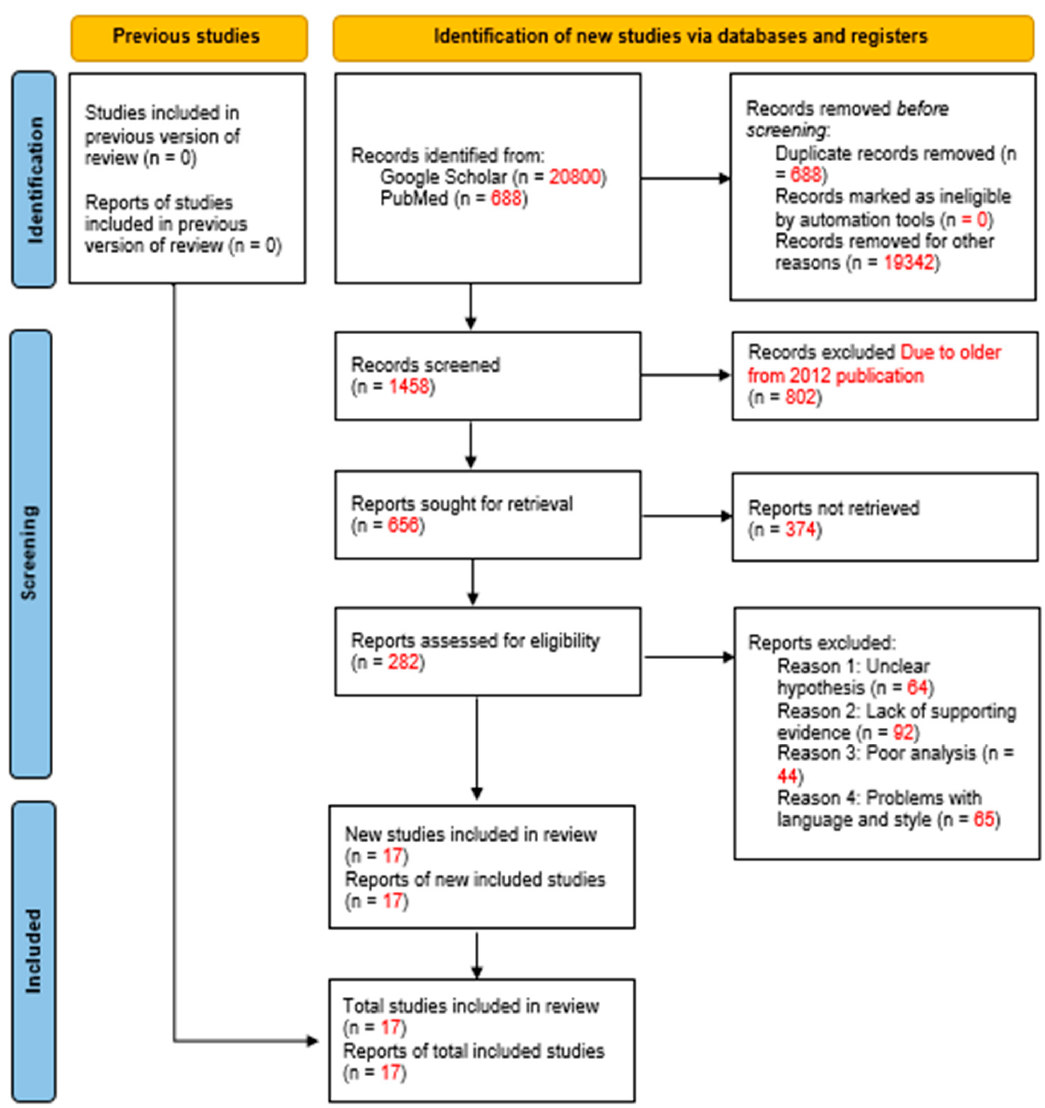
Figure 3. PRISMA for the third category (Ontologies for NDs) .